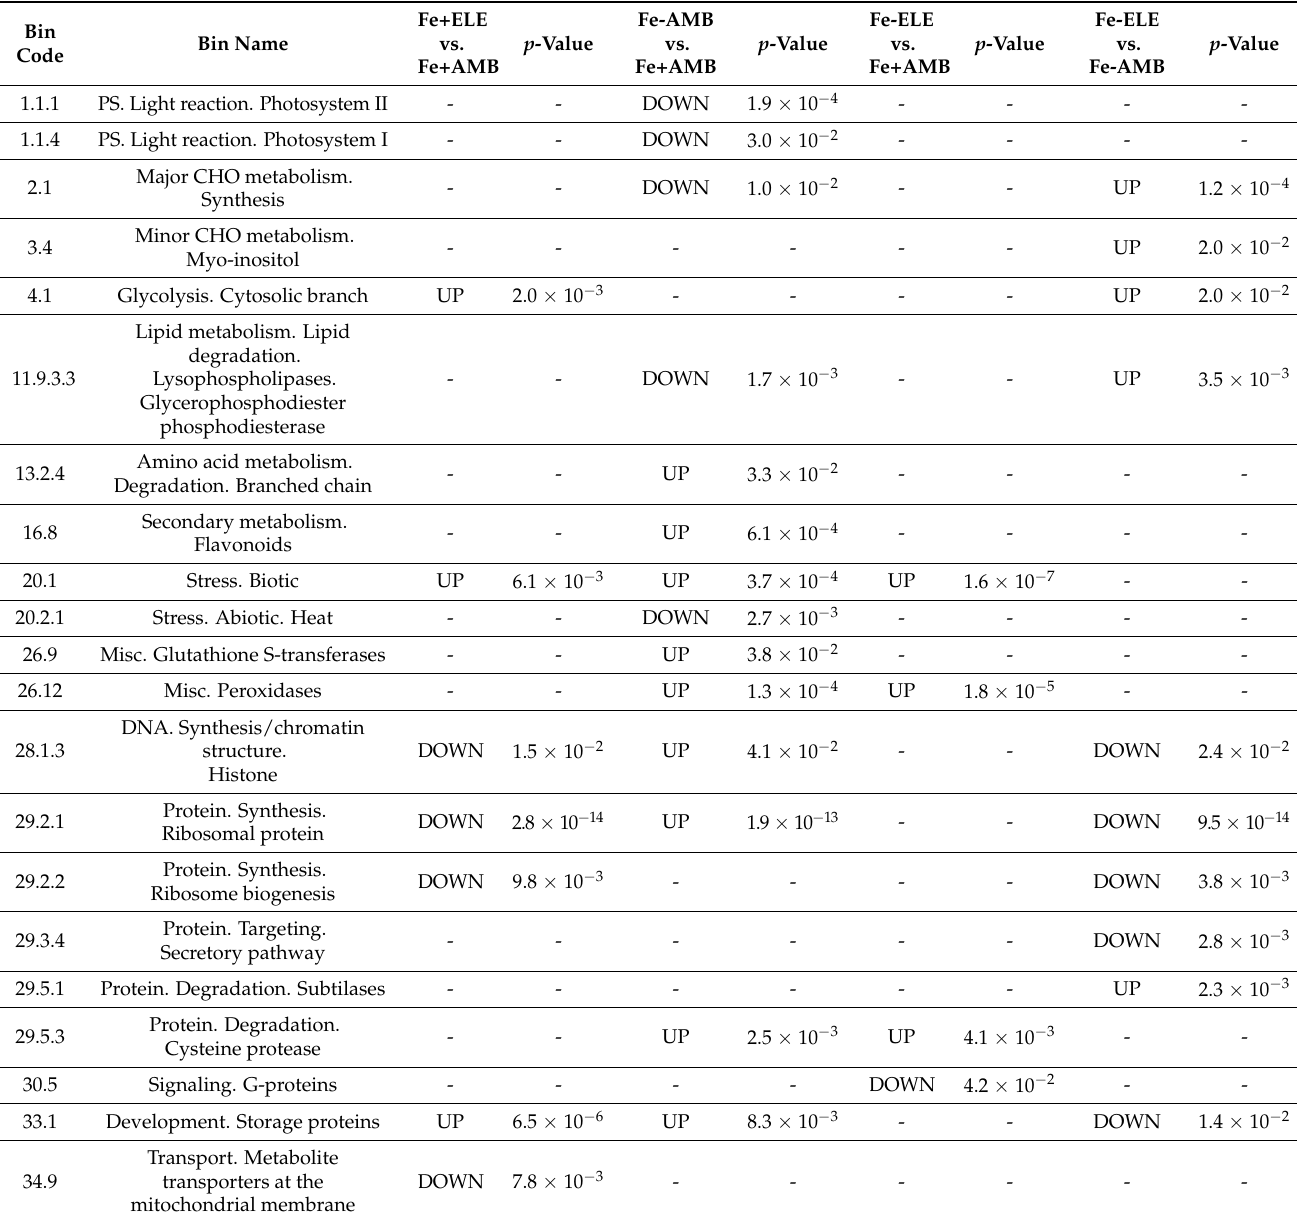
Table 3. Pathway enrichment analysis in leaves of soybean plants under eCO 2 and